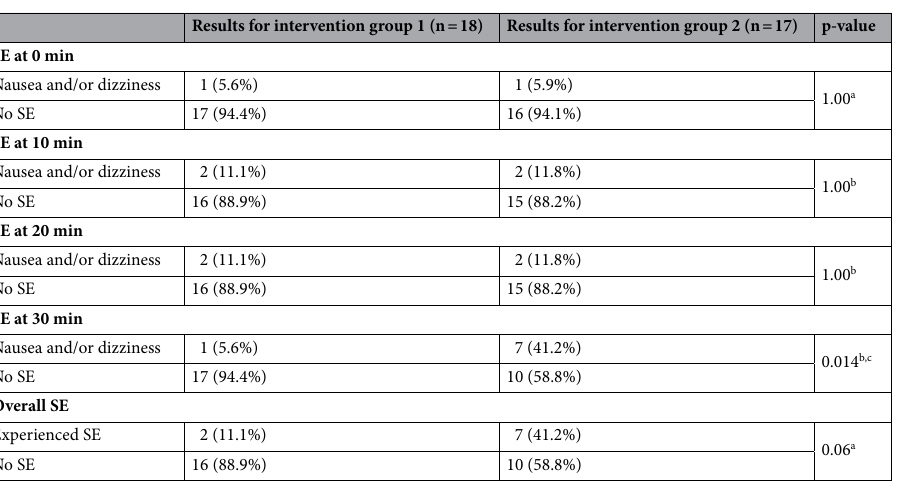
Table 3. The side effects (SE) reported by participants at 0, 10, 20 and 30 min and the total number of participants that experienced side effects. a Fisher’s exact test, b Fisher–Freeman–Halton exact test. c Denotes